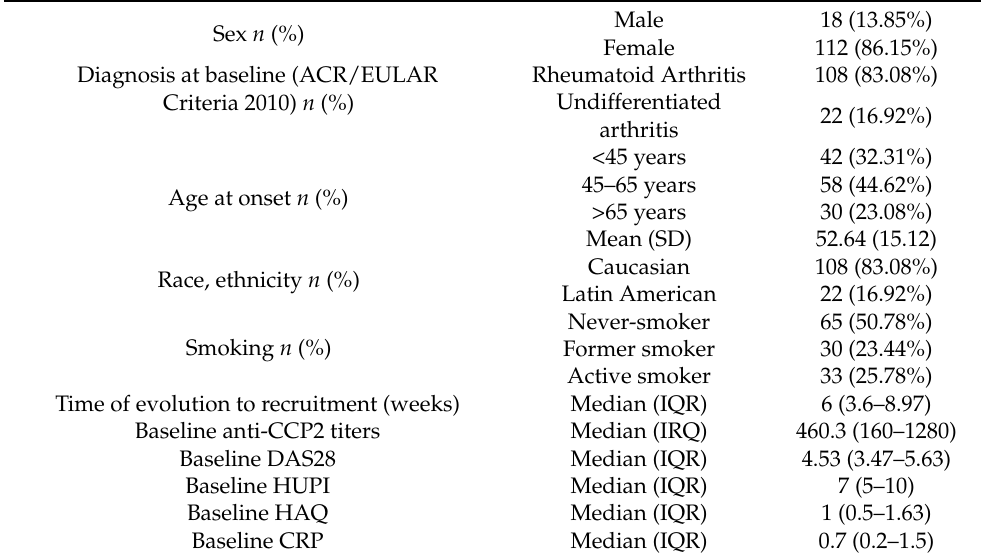
Table 1. Characteristics of the population at recruitment (Visit 1).